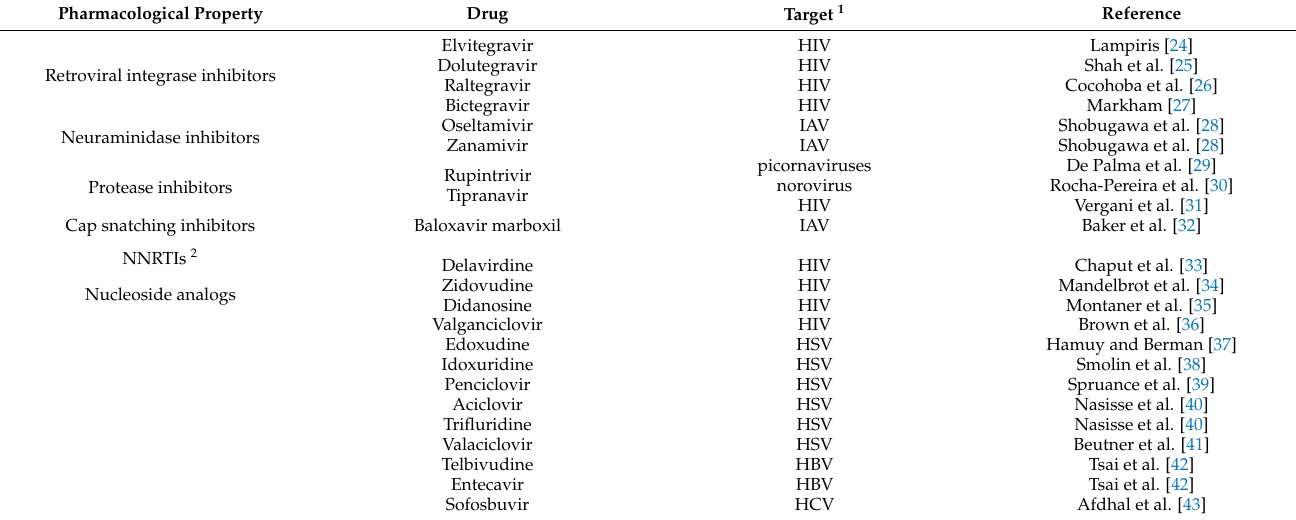
Figure 4. Antiviral drugs with nitrogen lone-pair conjugation near the Michael acceptor moiety. The α , β -unsaturated carbonyl motifs (red bonds and atoms) are interfered by nitrogen lone-pair conjugation (green nitrogen) to form deactivating carbonyl groups, resulting in less or no chance of the Michael addition reaction. The structures of ( A ) dolutegravir, ( B ) Biktarvy, ( C ) baloxavir marboxil, ( D ) delavirdine, ( E ) zidovudine, ( F ) edoxudine, ( G ) idoxuridine, ( H ) trifluridine, ( I ) telbivudine, and ( J ) sofosbuvir show one or two nitrogen lone-pairs causing resonance near the Michael acceptor moiety. Table 1. List of antiviral drugs containing an α , β -unsaturated carbonyl